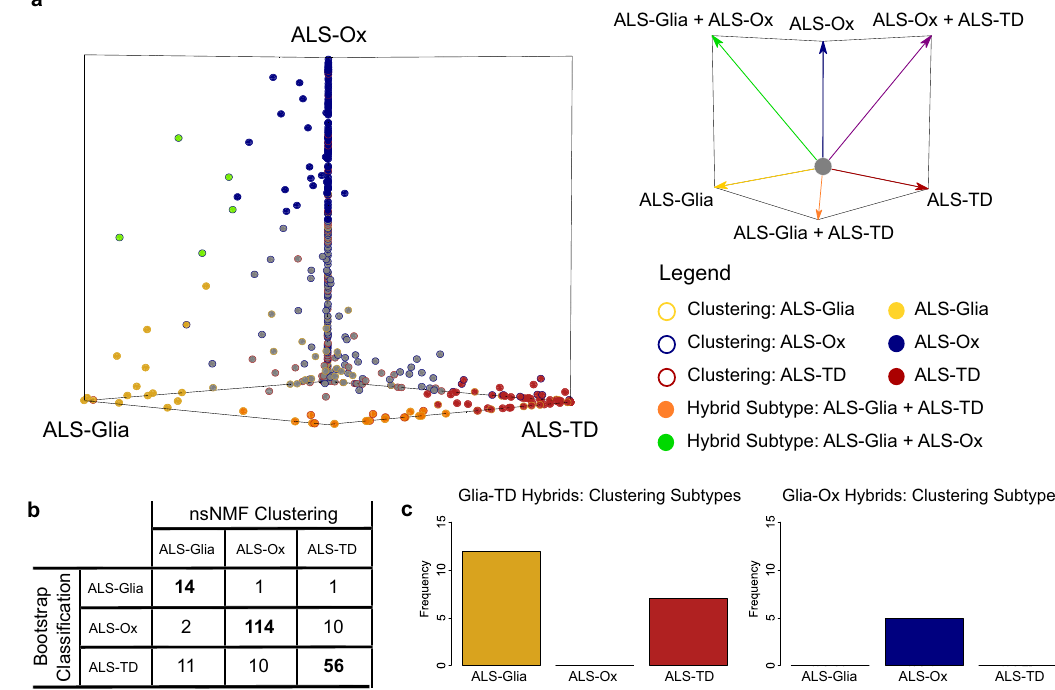
Fig. 4 | Score-based classi fi cation uncovers hybrid subtype states in the ALS cohort. a Subtype scoring was implemented with bootstrapping to assess the spectrum of disease phenotypes presented in ALS. Each point corresponds to a singletranscriptomederivedfromthefrontalormotorpostmortemcortex, n =451 biologically independent samples. Patient samples were initially placed at the ori- gin,movedinthedirectionofthesubtypeaxisforeachroundofbootstrappingthat passed the subtype score threshold, and could only reach the vertex if the patient sample passed the threshold in all rounds of bootstrapping. Data points are fi lled